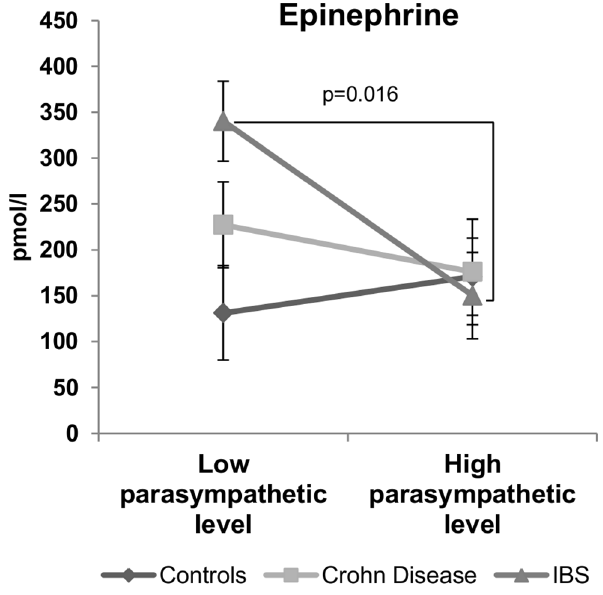
Figure 4. Specific inverse relationship between the resting parasympathetic vagal tone and epinephrine plasma level in IBS patients. IBS patients with low parasympathetic vagal tone exhibit a higher level of plasma epinephrine at rest than those with high parasympathetic vagal tone. This inverse relationship was not observed in controls or CD patients. Data are expressed as mean 6 sem. Comparisons are made between the high and low parasympathetic level subgroups using permutations test. catecholamines within each group (controls, IBS and CD). Data